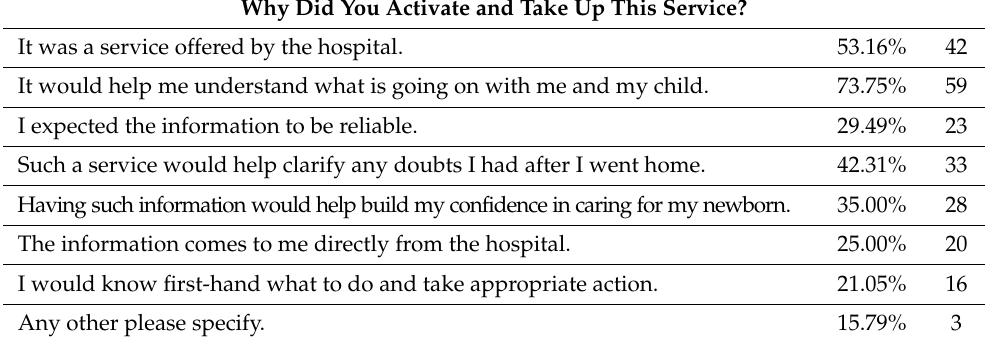
Table 2. Reasons for engaging in the service ( n =